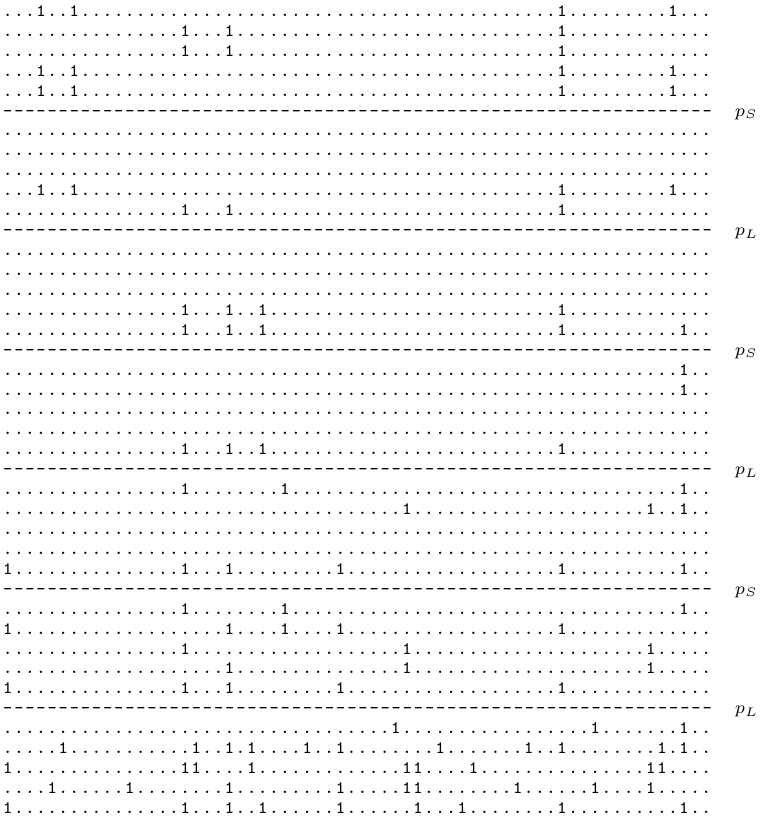
Figure 5: 4-round trail with 44 [6, 5, 9, 24] active Sboxes and weight 126 [13, 15, 25,